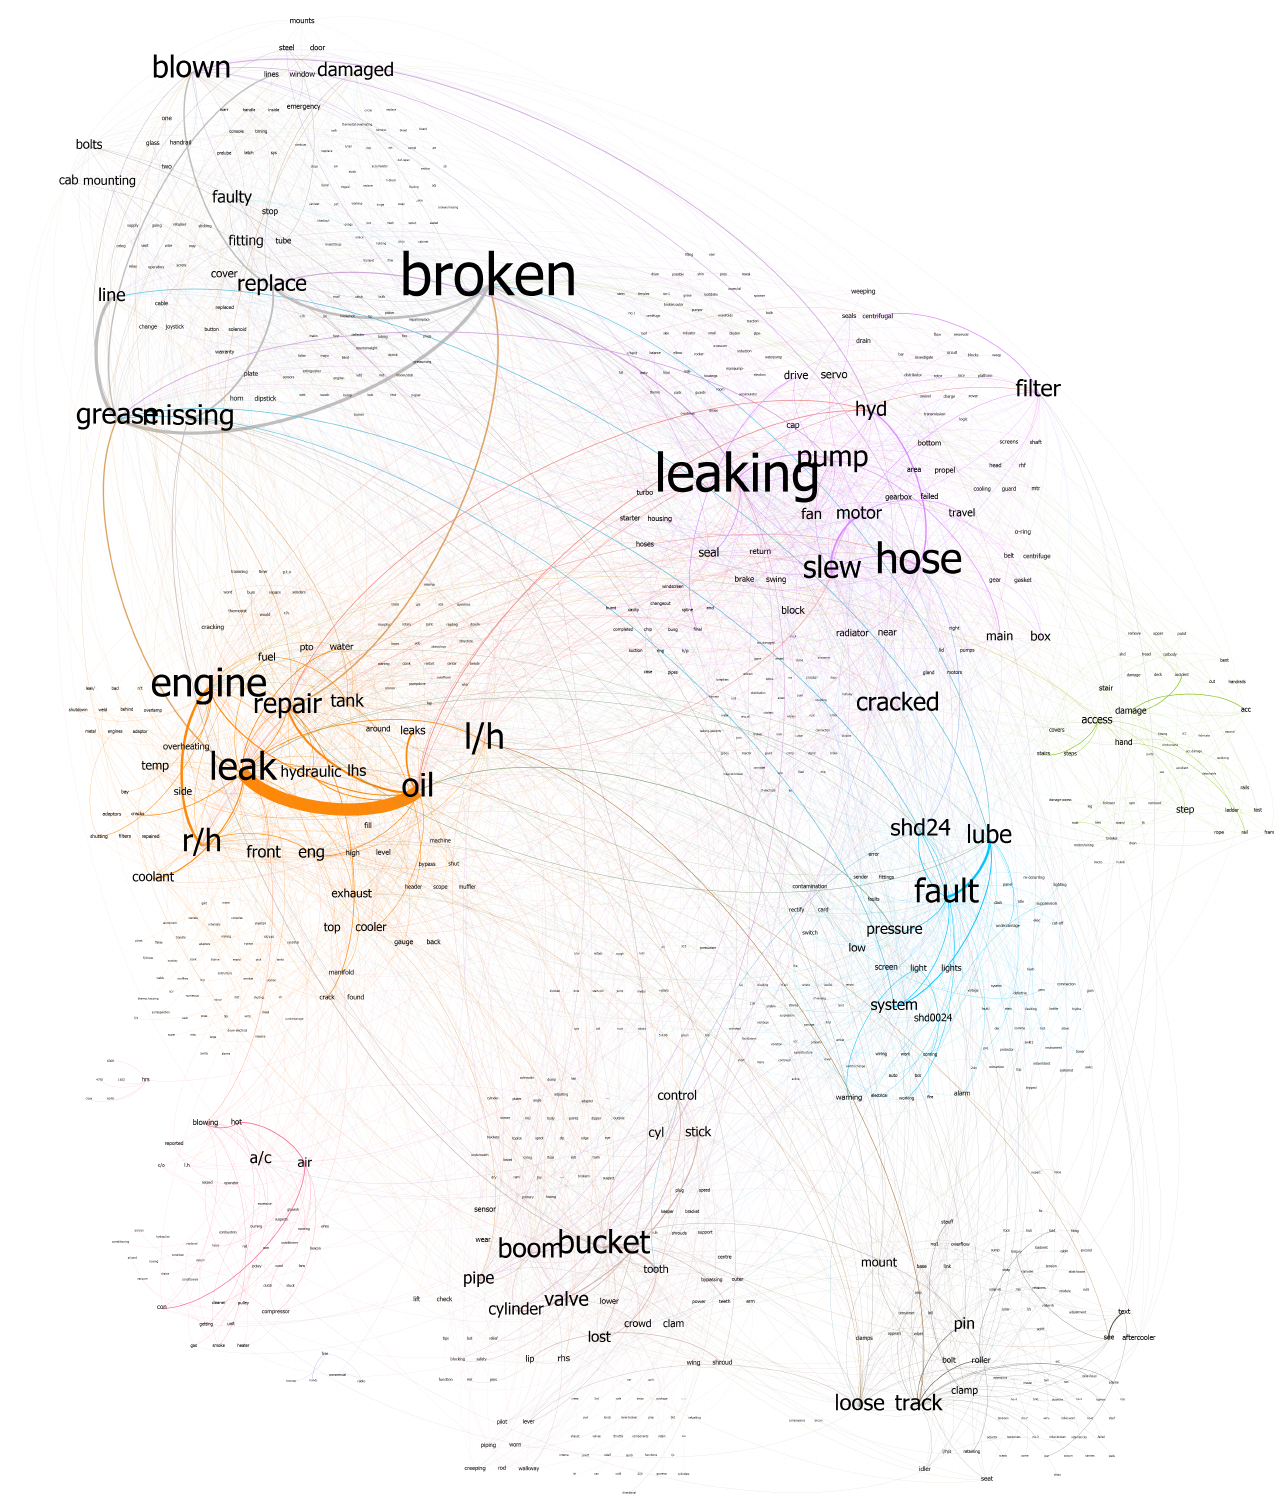
Figure 7. Complete co-occurrence network of